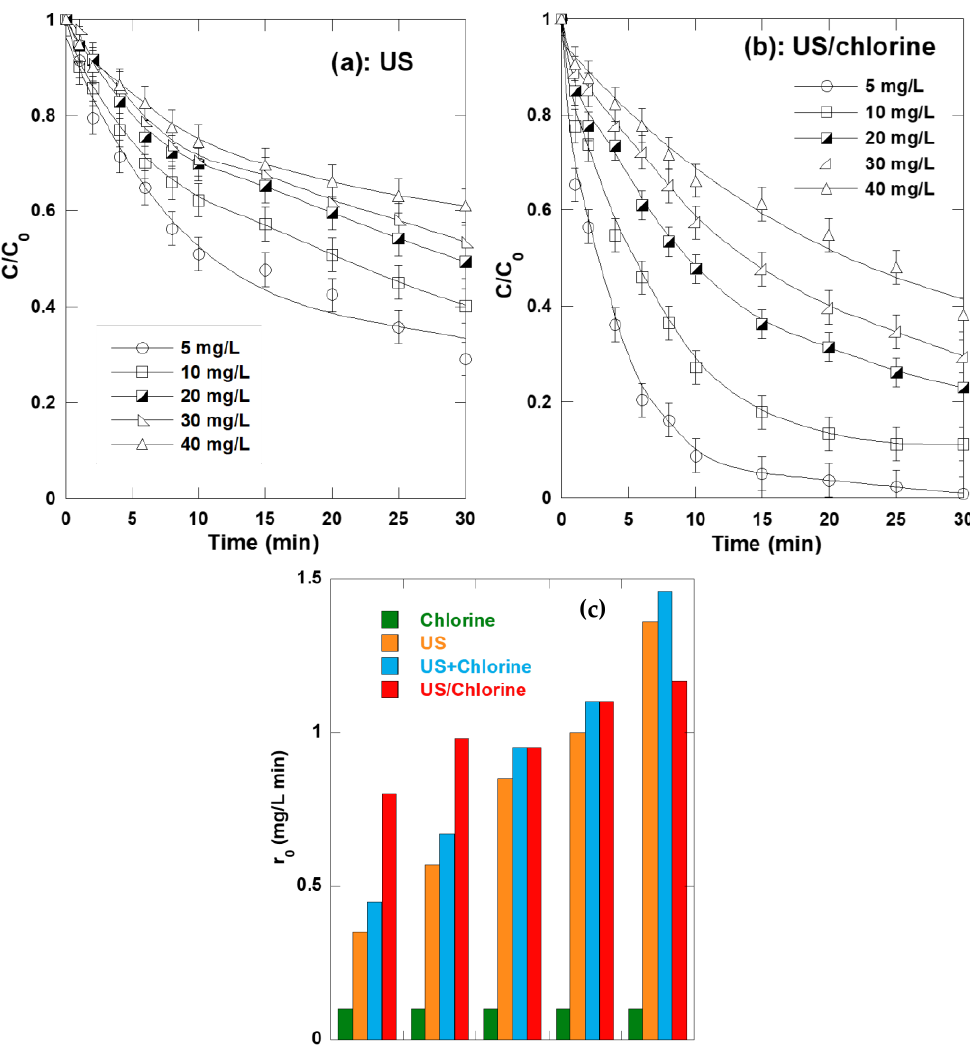
Figure 7. Effect of initial dye concentration on the performance of US ( a ) and US/chlorine ( b ) processes toward the removal kinetics of ARAC (conditions: C 0 = 5 – 40 mg·L − 1 (10 µM), [chlorine] 0 = 250 µM, V = 150 mL, pH 5.5, temperature: 25 ± 1 °C, frequency: 600 kHz, power: 120 W) and variation in ARAC initial removal rate (r 0 ) with respect to initial de concentration for chlorination alone, US alone and US/chlorine combination ( c ) (the sum of the two processes separately, US + chlorine, was added for comparison with the combined process).